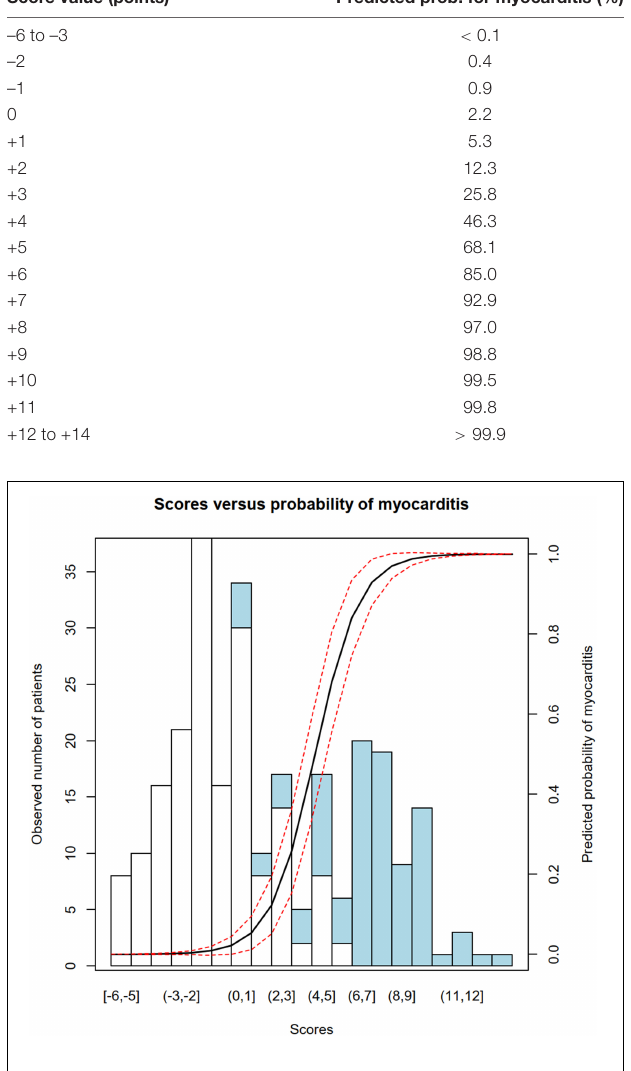
FIGURE 2 | Plot of predicted probability vs. observed values in the three-fourths cohort ( n = 266).